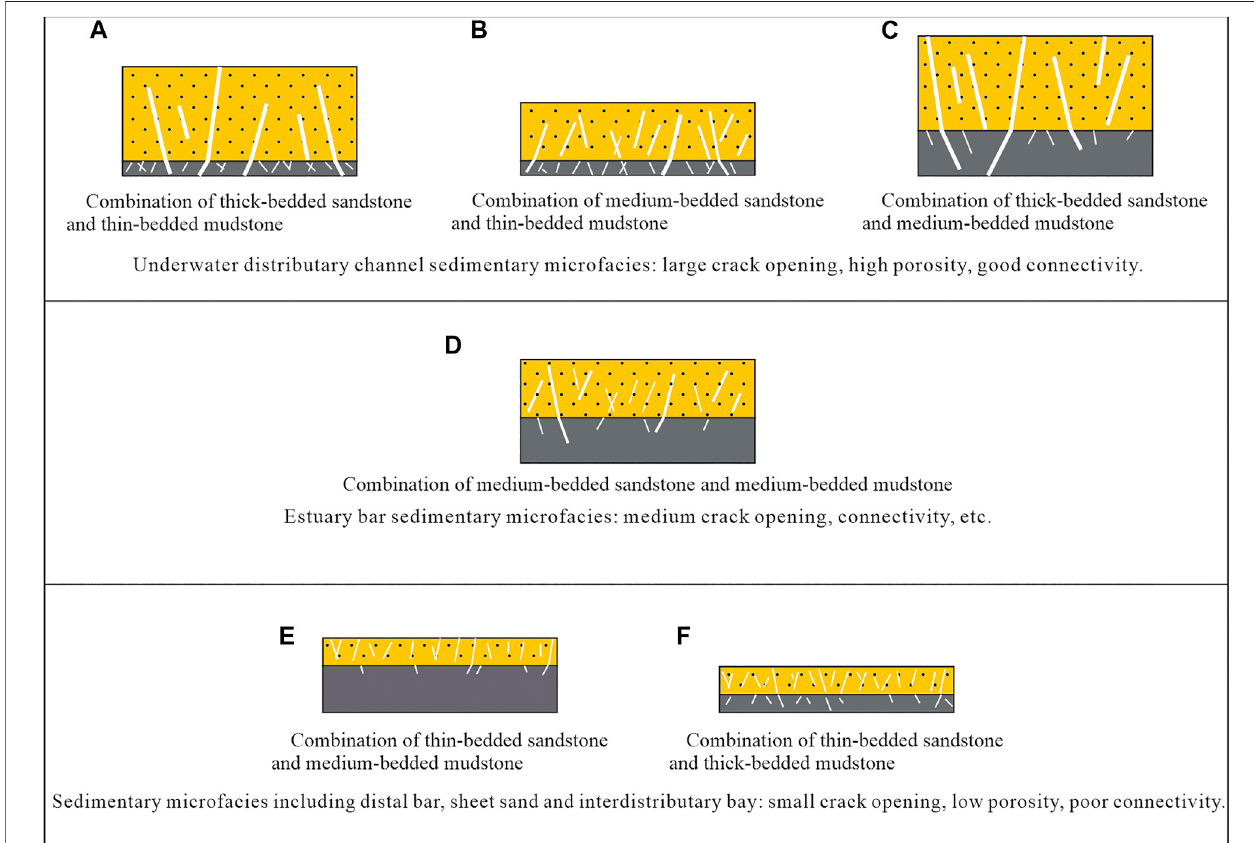
FIGURE 14 | Schematic of reservoir crack development models of the lithological combinations corresponding to various sedimentary microfacies.